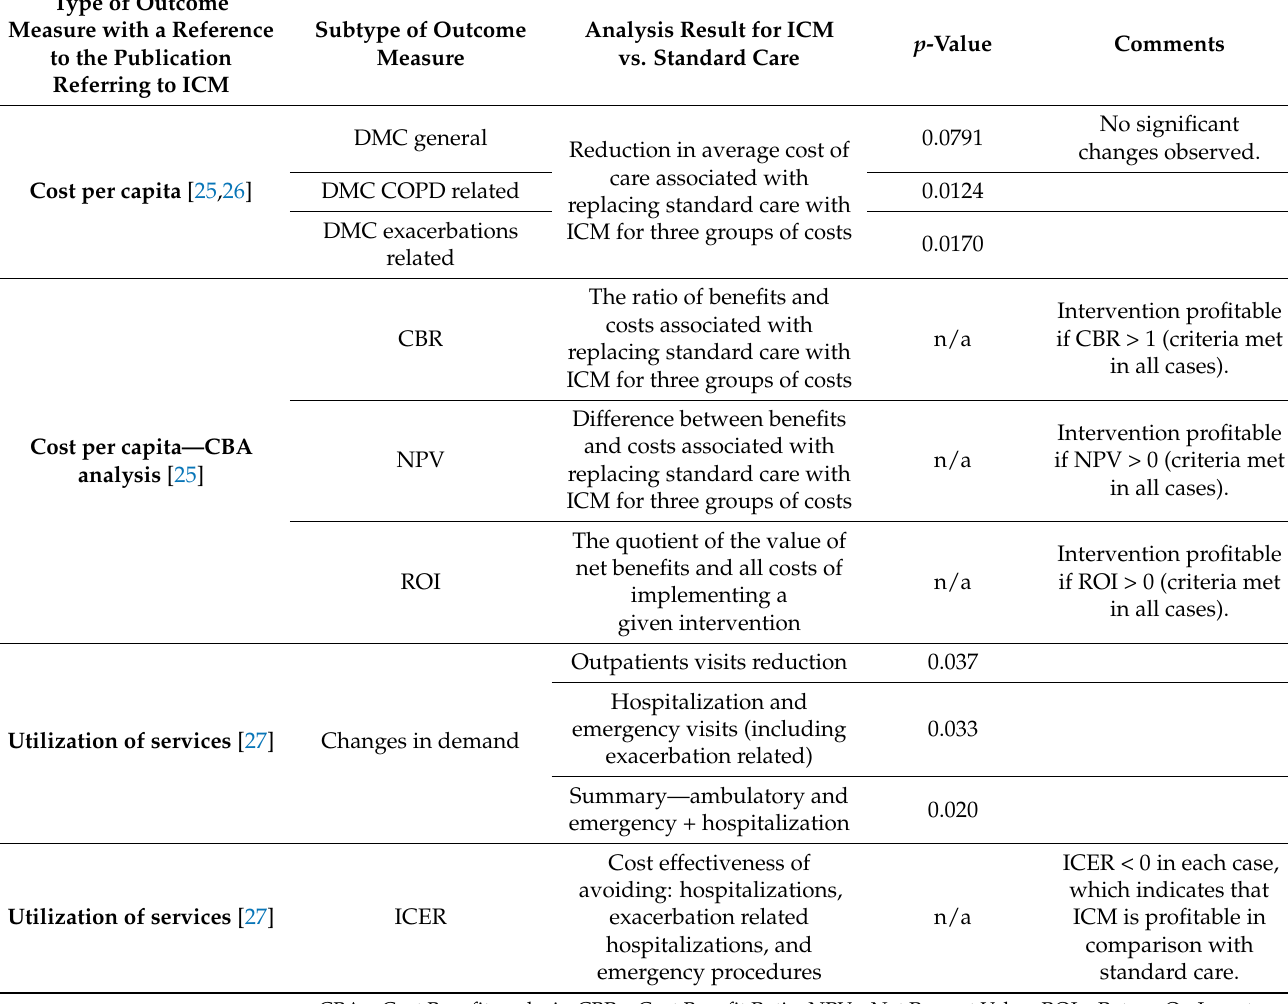
Table 2. Available results of economic effectiveness of ICM (including ICER). Summary based on publications referring to ICM